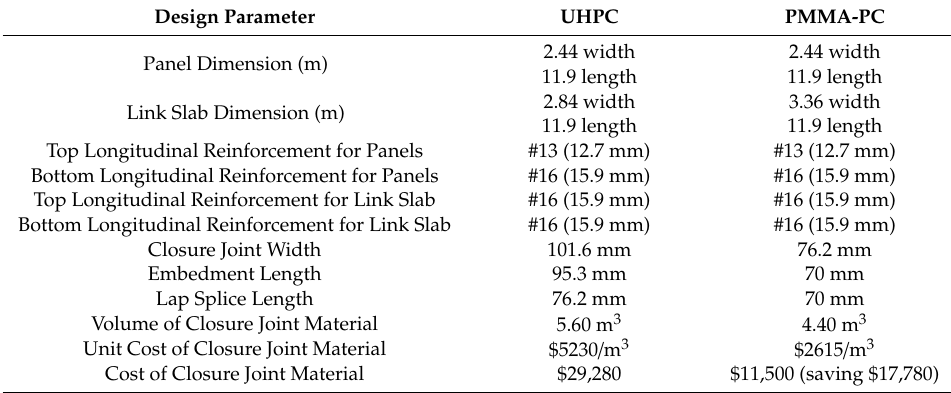
Table 4. Design Comparison Between UHPC and PMMA-PC Closure